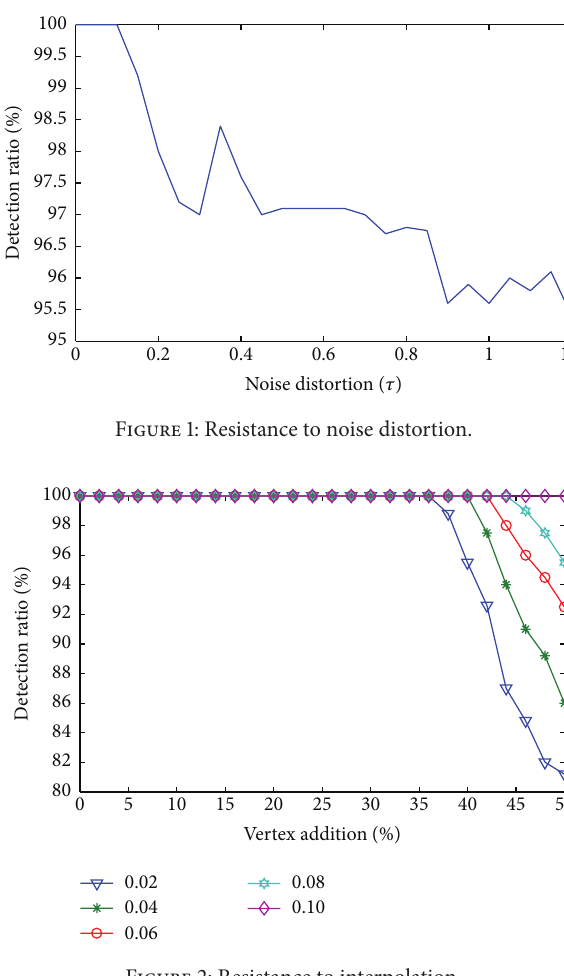
Figure 2: Resistance to